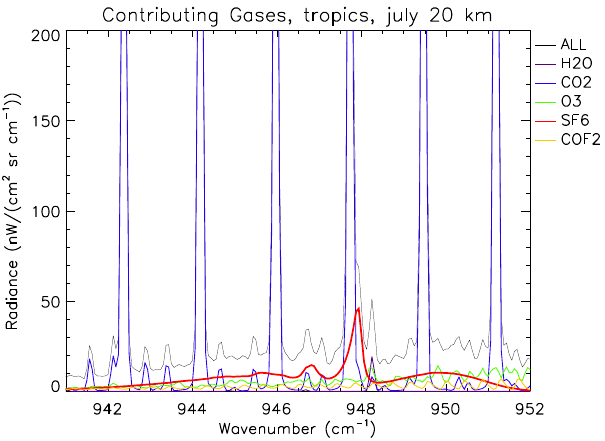
Figure 1. Contributing trace gases to a typical spectrum measured at midlatitudes in July at 20km (low resolution) with the SF 6 signature in